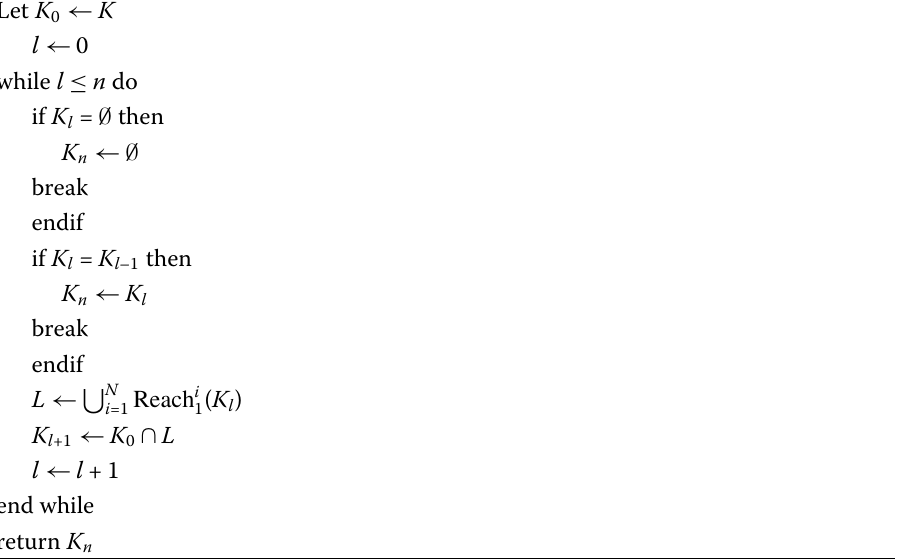
Algorithm 1 The viability kernel of discrete-time switched